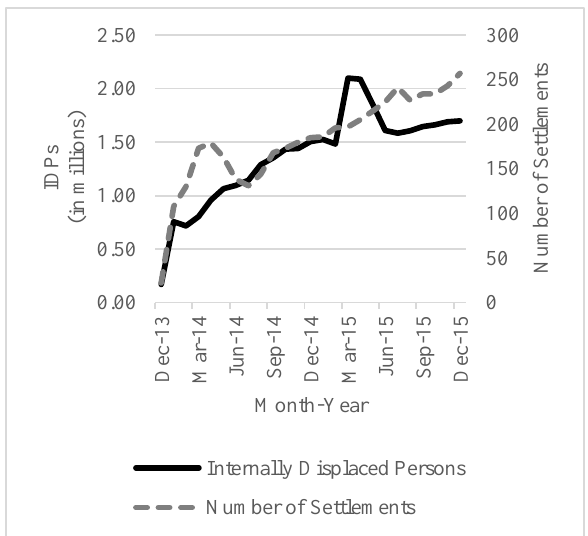
Figure 3. Internally Displaced Population Totals and